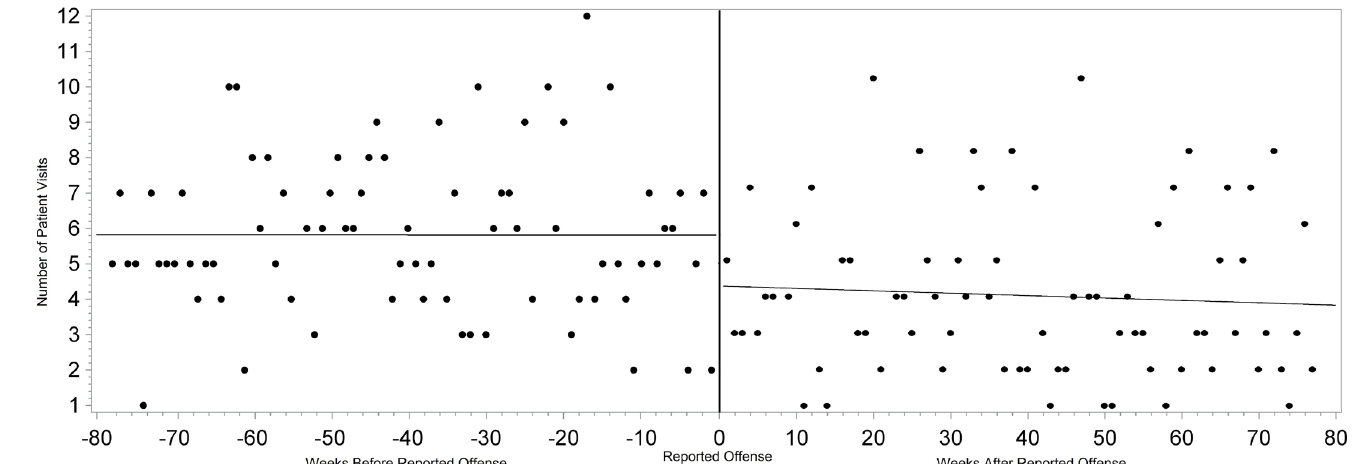
Figure 3. Correlation between number of non-emergency department visits and the time from each victim’s reported date of offense.